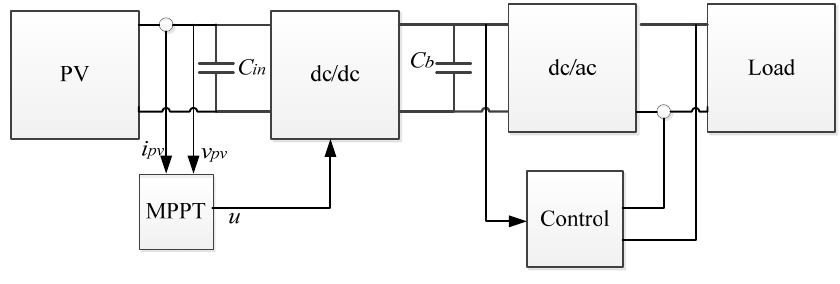
Figure 1. Typical structure of a photovoltaic (PV) system.